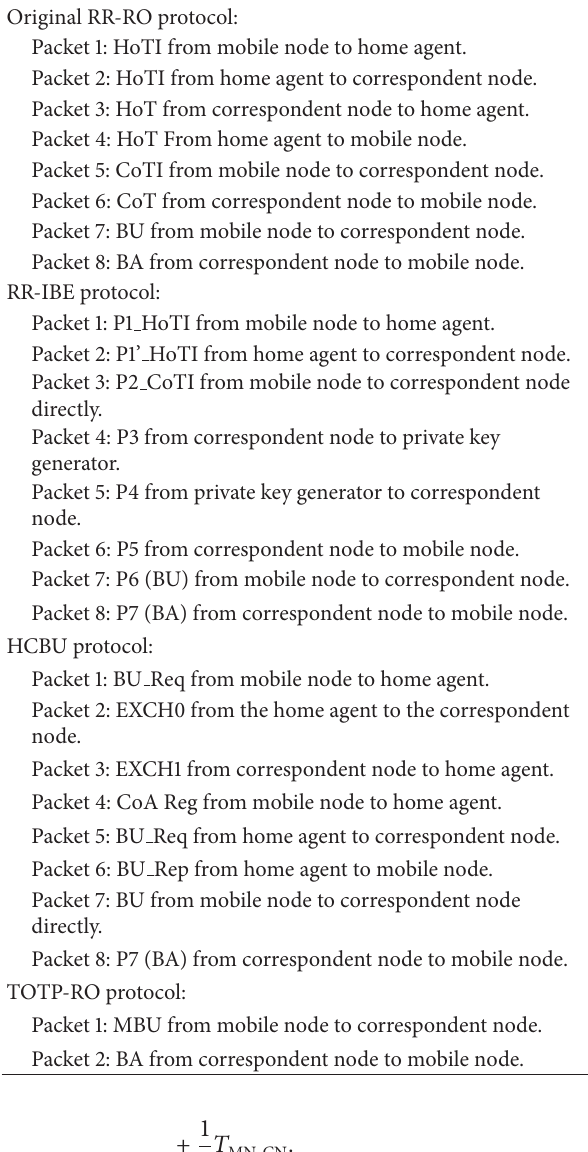
Table 2: A number of messages comparison for different Route Optimization